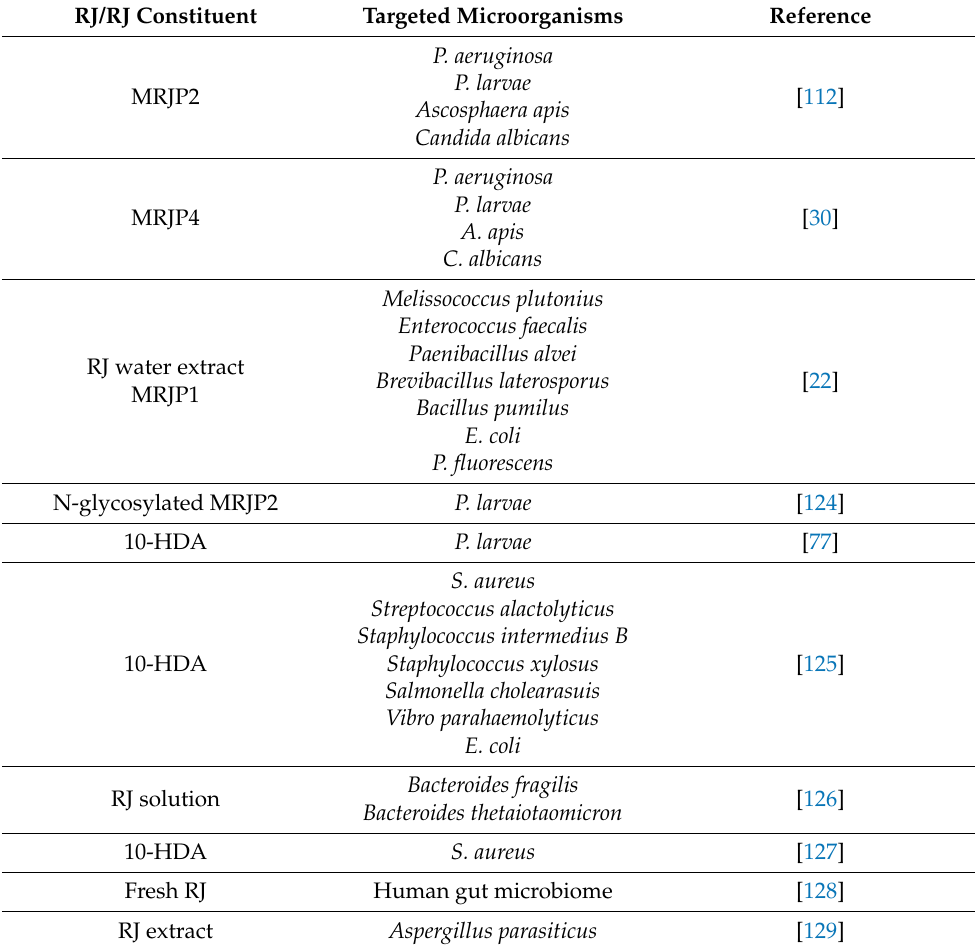
Table 1. RJ antimicrobial and antifungal activities against target